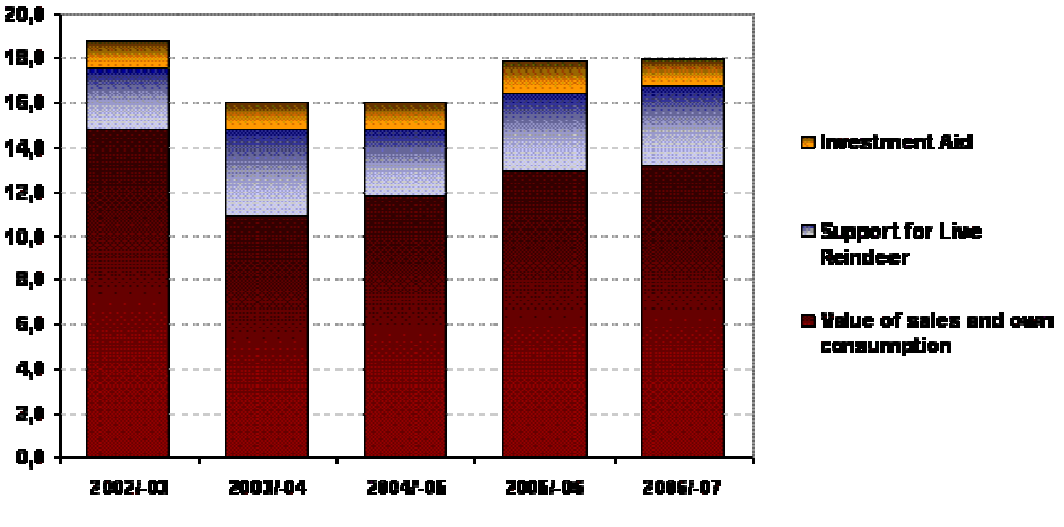
Fig. 1. Total revenue of reindeer husbandry in 2002-